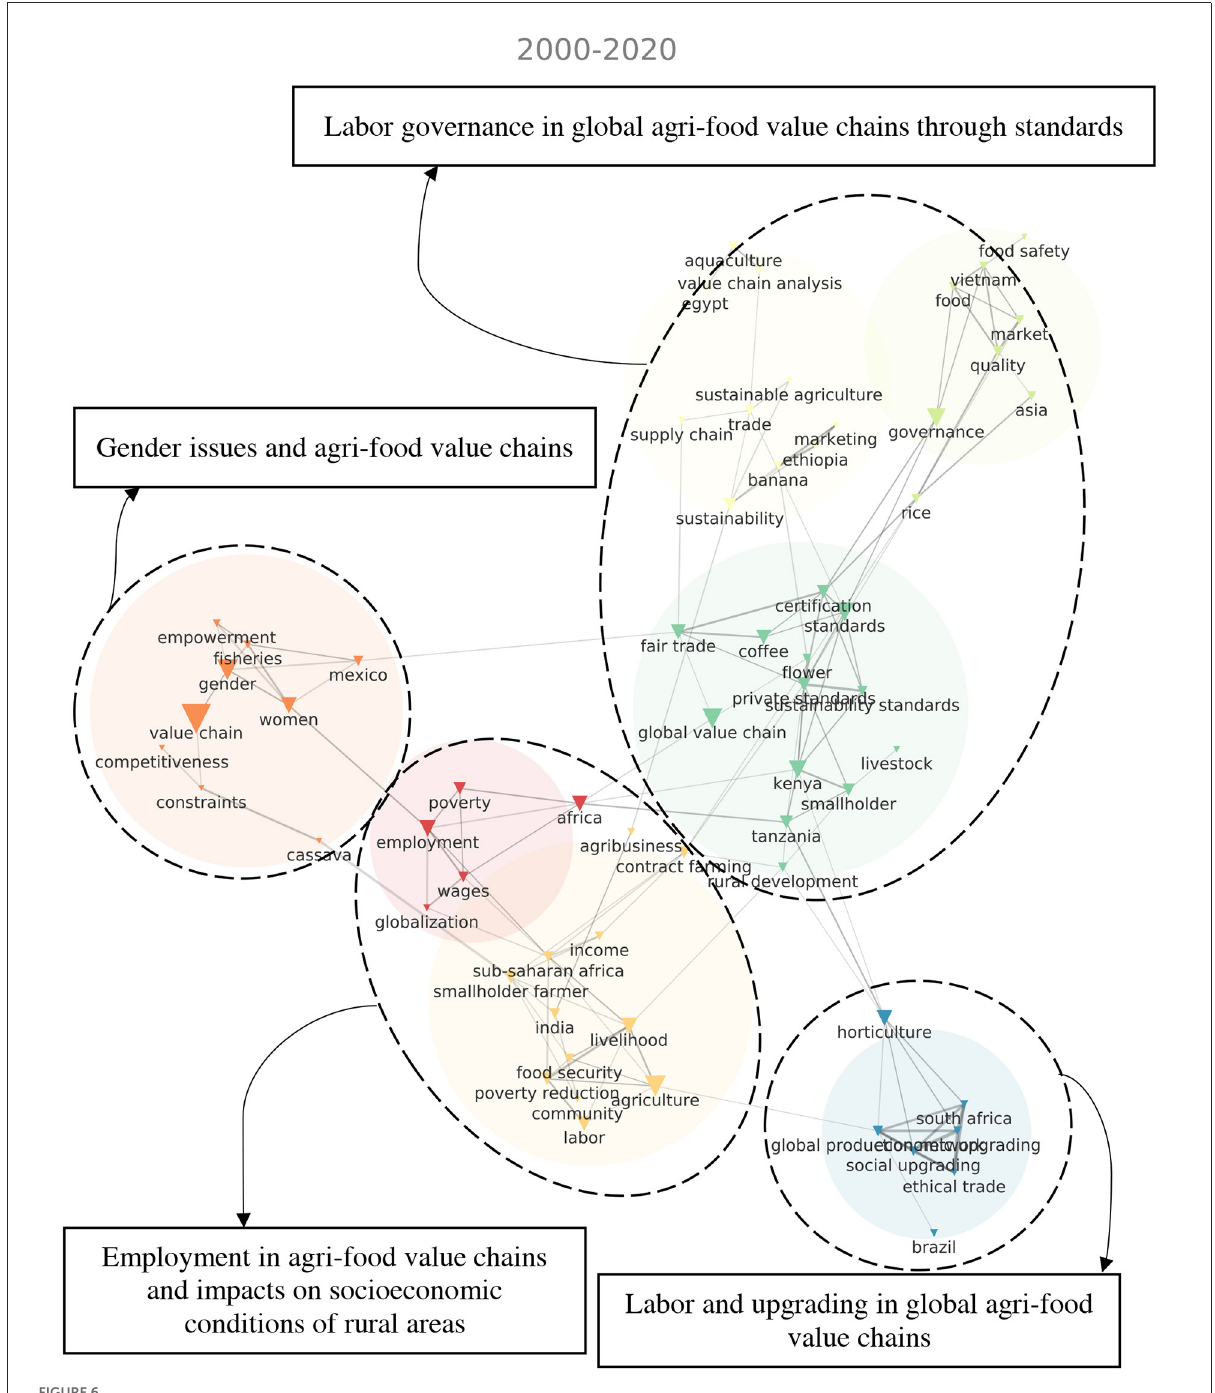
FIGURE6 Network map of scientific knowledge on labor in agri-food value chains for the period 2000–2020. Four research domains are identified: (1) labor governance in global agri-food value chains through standards, (2) employment in agri-food value chains and impacts on socioeconomic conditions of rural areas, (3) gender issues and agri-food value chains, (4) labor and upgrading in global agri-food value chains.